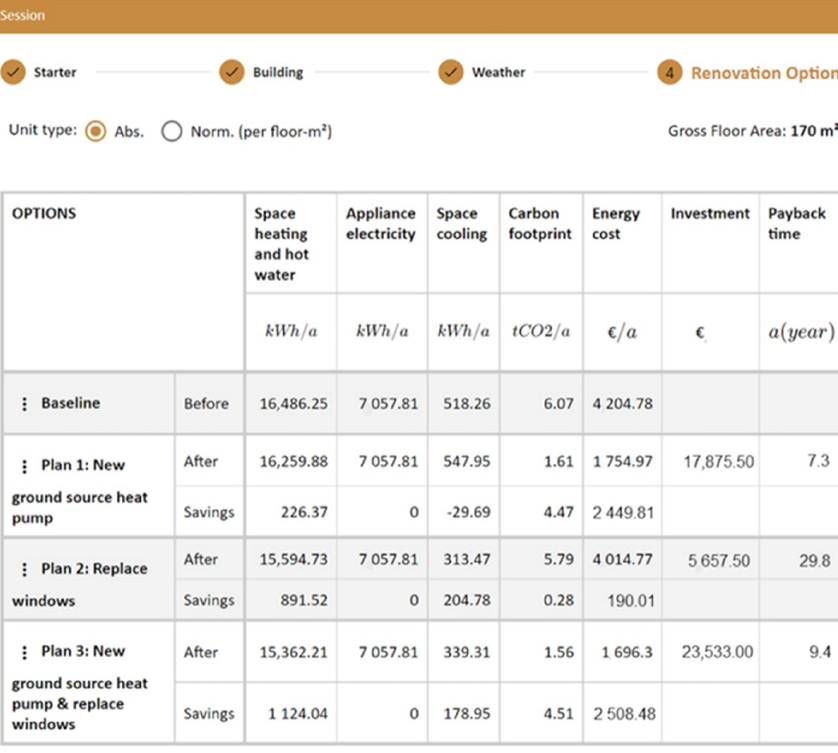
Figure 8. Retrofitting tool GUI: Results.